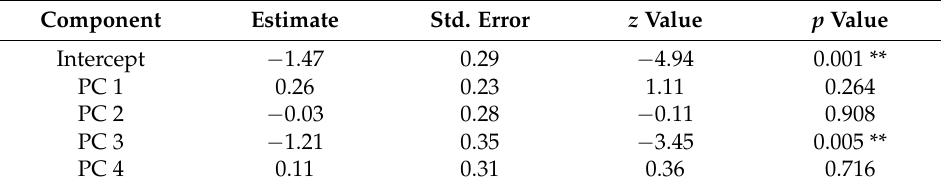
Table 6. Principal Components (PC3) and the anatomical structures of males of N . elegantalis .